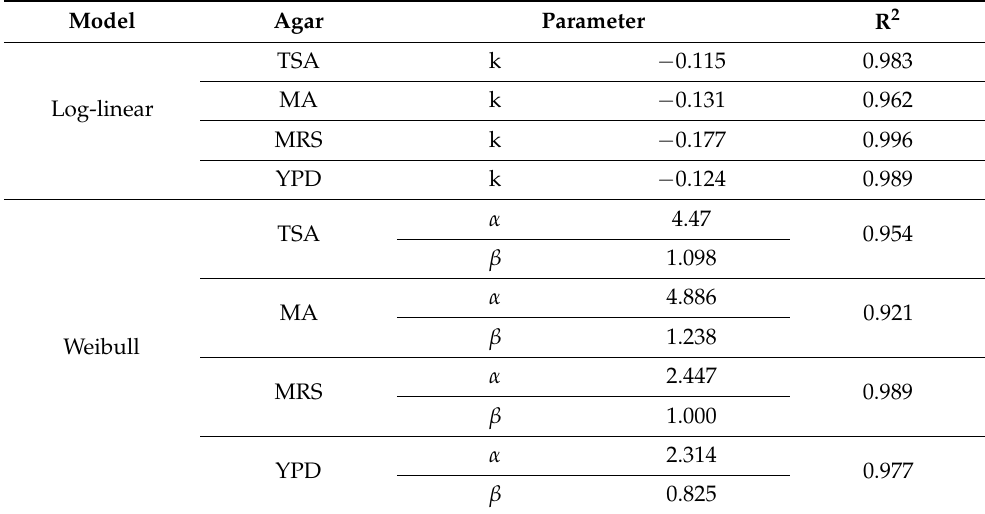
Figure 4. The effect of underwater plasma treatment on the population of microorganisms in WB. Table 2. Evaluation of the log-linear model and Weibull model to estimate the reduction of microorganisms in WB by underwater plasma treatment.